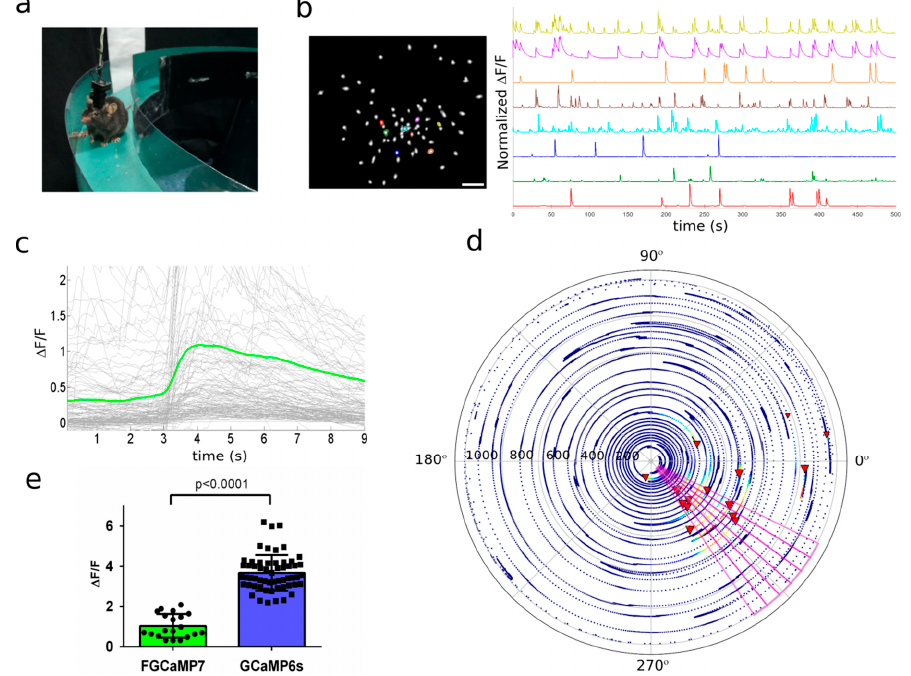
Figure 6. In vivo neuronal Ca 2 + activity in the hippocampus of freely behaving mice visualized using FGCaMP7 and an nVista HD miniscope. ( a ) Photo of O-shaped track and mouse which explores it with an nVista HD miniscope mounted on its head. ( b ) Spatial filter and sample traces obtained from a 15-min imaging session of freely behaving mouse expressing FGCaMP7 GECI. ∆ F / F 0 values were normalized to the maximal ∆ F / F 0 for each trace. Scale bar: 100 µ m. ( c ) Mean spike for FGCaMP7